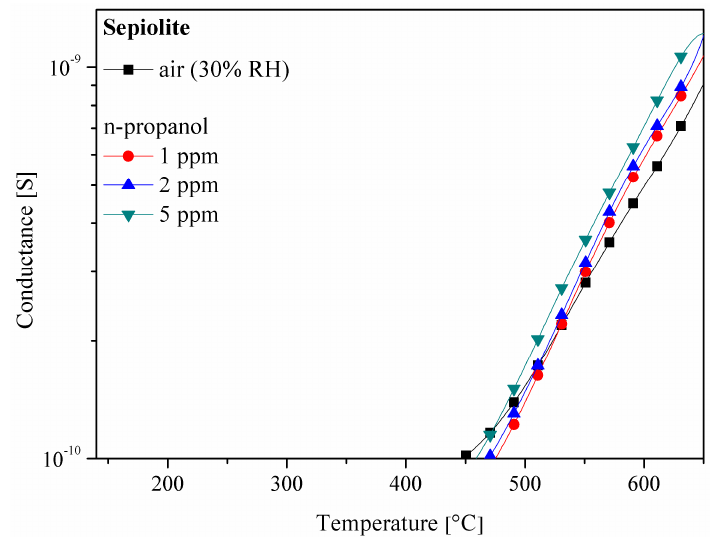
Figure 5. The effect of the composition of the atmosphere on the temperature changes of the conductance in the sepiolite layer. According to the catalogue data, the lower range of the Solartron SI 1287 meter used was 0.4 nA.